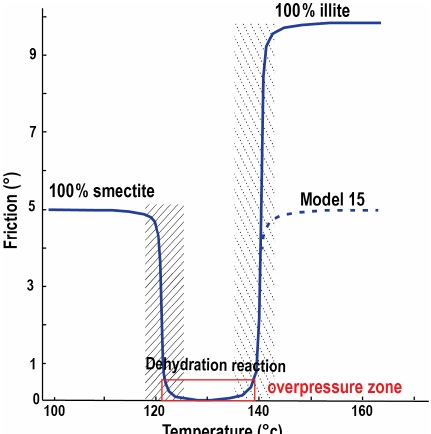
Figure 7. Evolution of friction with temperature with our param- eterization of smectite–illite transition. The dashed line is for the evolution of friction in simulation M15 which serves as comparison with M1 at the brittle–ductile transition